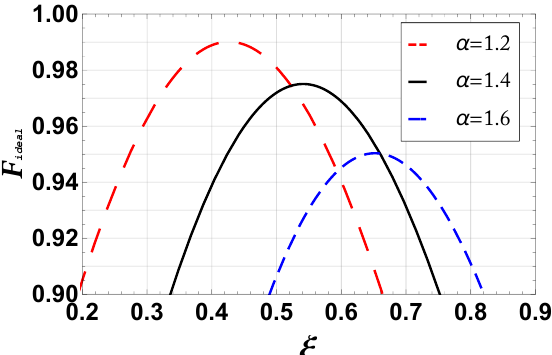
Figure 2. Fidelity F ideal between an ideal single-photon subtracted SVS | ψ 3 Sq ( ξ ) (cid:105) and an odd SCS | SCS − (cid:105) for α = 1.2, 1.4, and i α